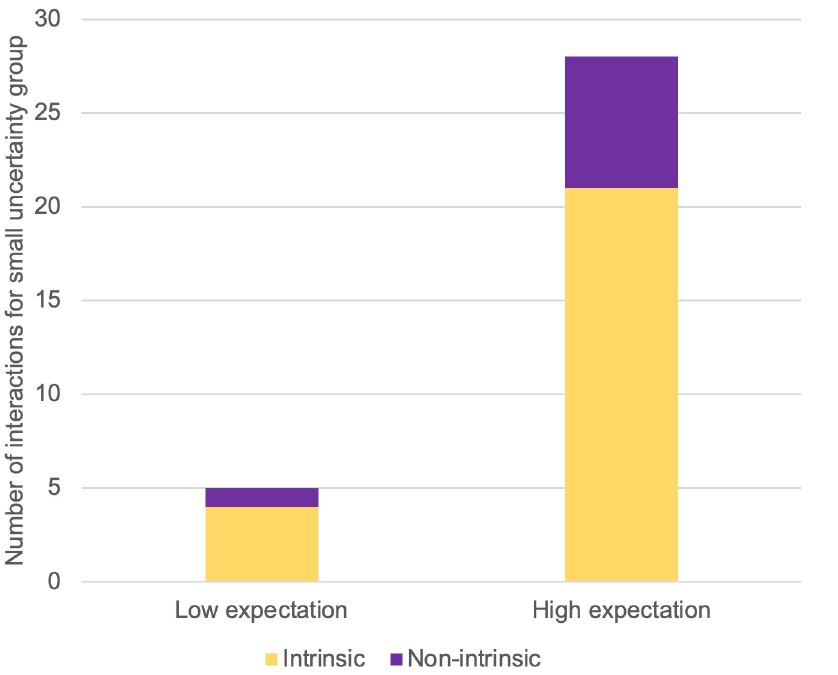
Fig 12. Numbers of interactions for small-uncertainty group, sorted by motivation type.